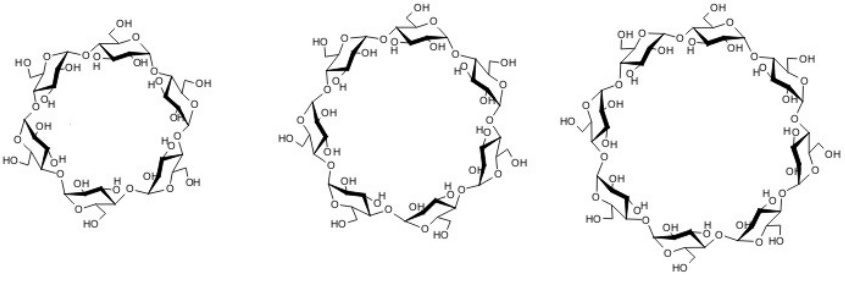
Figure 1. α -, β -, and γ -cyclodextrins’ structures.